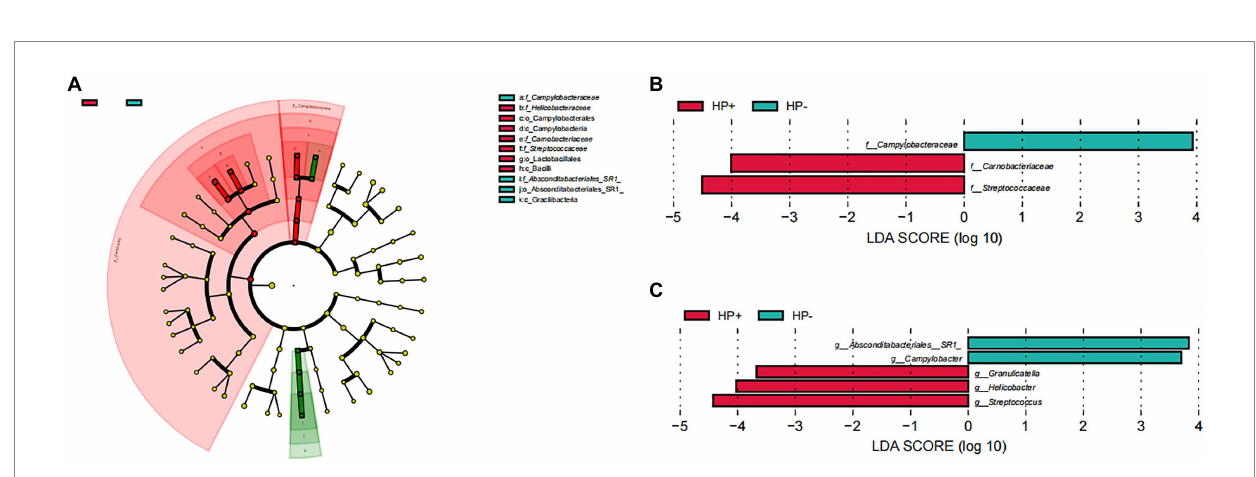
FIGURE 3 LEfSe analysis of GJM in HP − and HP+ PCG. Phylogenetic cladograms (A) , and barplots at (B) the family, and (C) Genus levels are